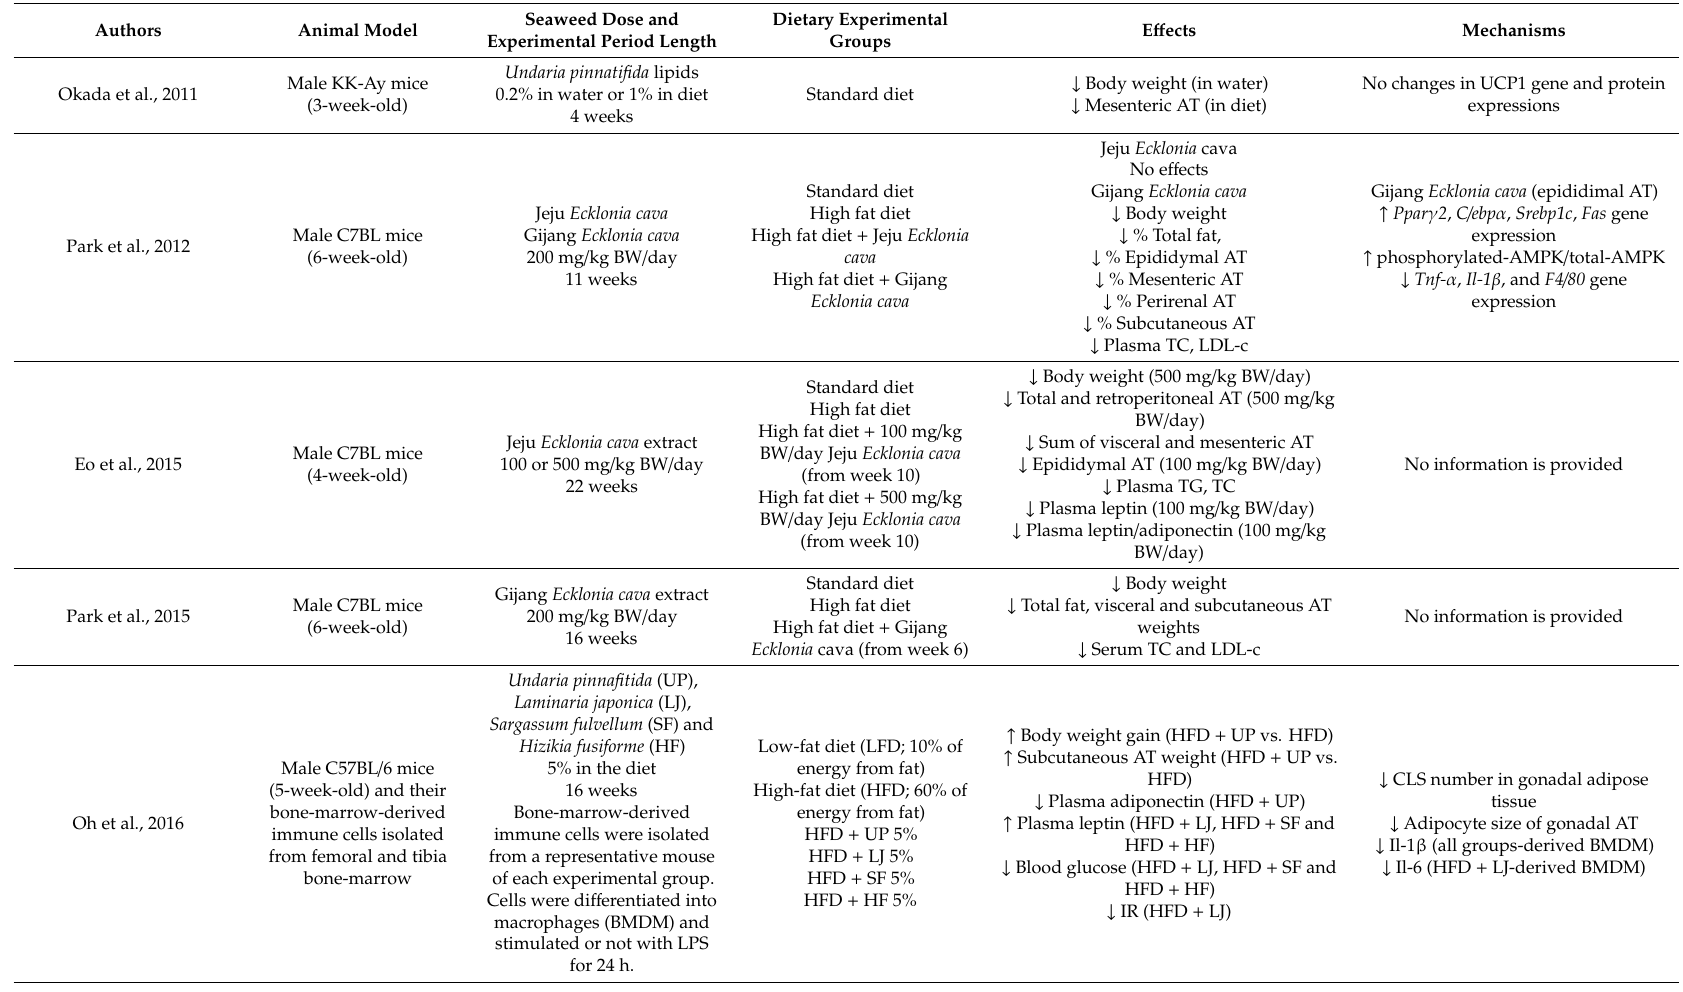
Table 2. In vivo e ff ects of brown seaweeds in di ff erent animal